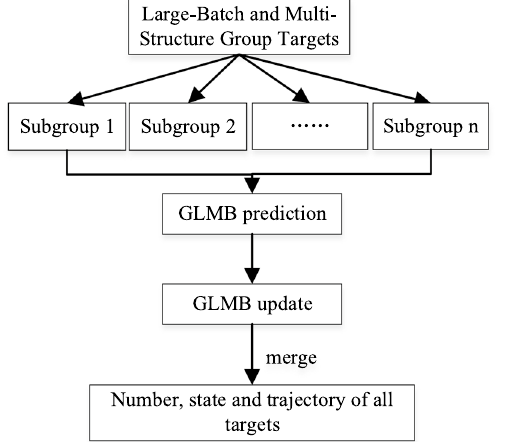
Fig. 2 Serial tracking algorithm for large-batch and multi-structure group